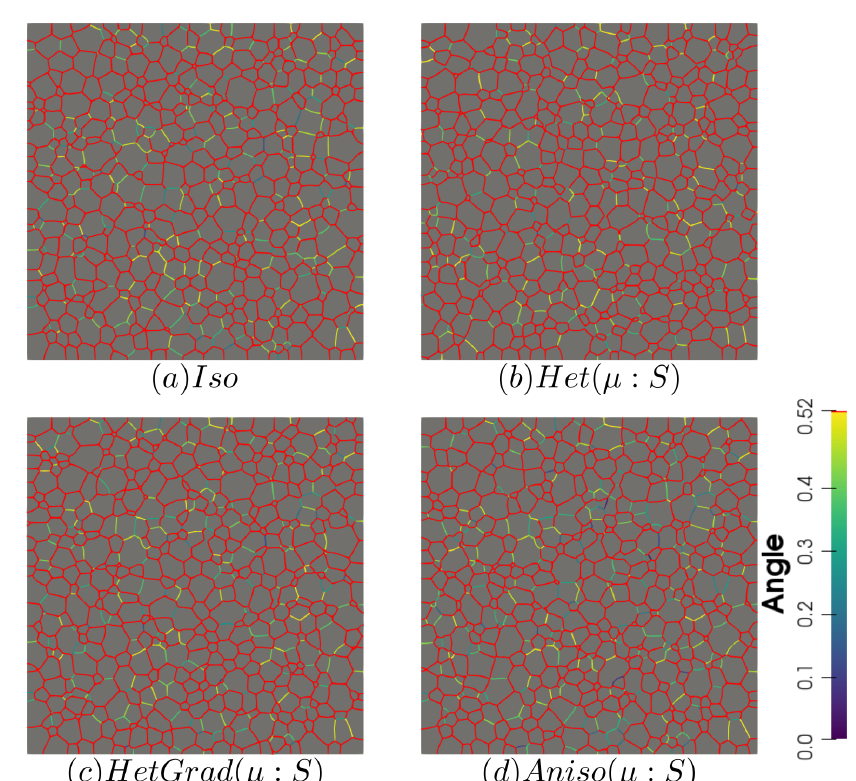
Figure 17. Disorientation of the boundaries using the four formulations with heterogeneous grain boundary mobility at t = 1 h. Boundaries with a disorientation higher than 30 ◦ are colored in red.